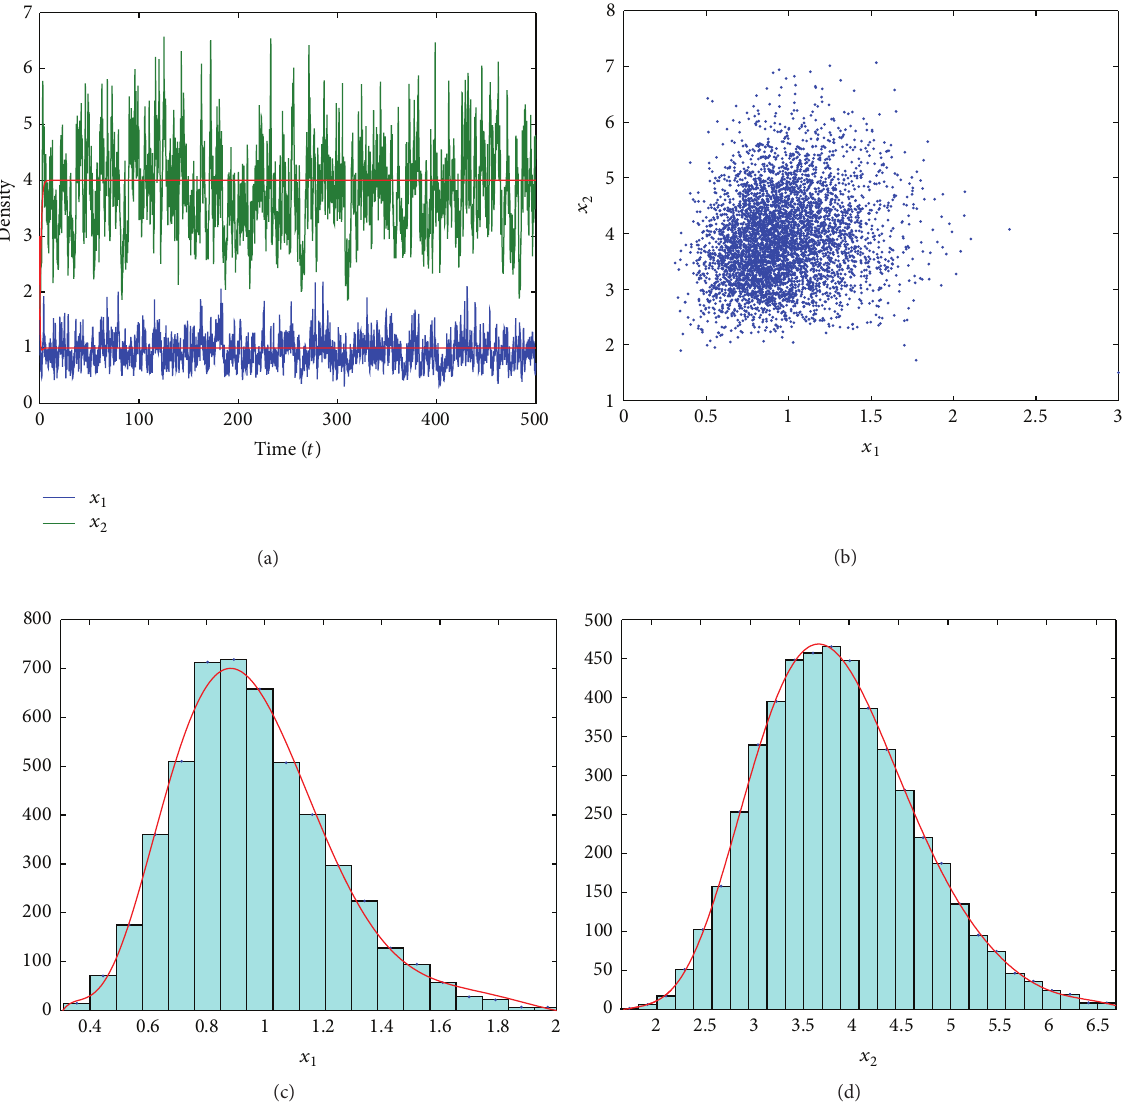
Figure2:NumericalsimulationsofExample 9.Inthisexample,wechoose 𝜀 21 sufficientlysmallsuchthatconditionsinTheorem